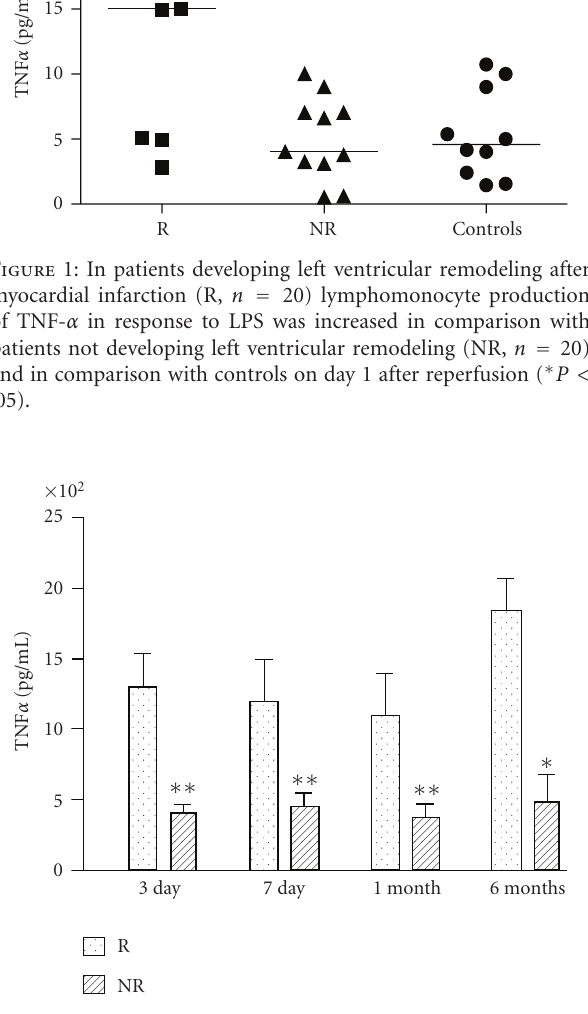
Figure 2: In patients developing left ventricular remodeling after myocardial infarction (R, n = 20) lymphomonocyte production of TNF- α in response to LPS was increased in comparison with patients not developing left ventricular remodeling (NR, n = 20) on day 3, on day 7, 1 month, and 6 months after reperfusion ( ∗ P < . 05, ∗∗ P < .